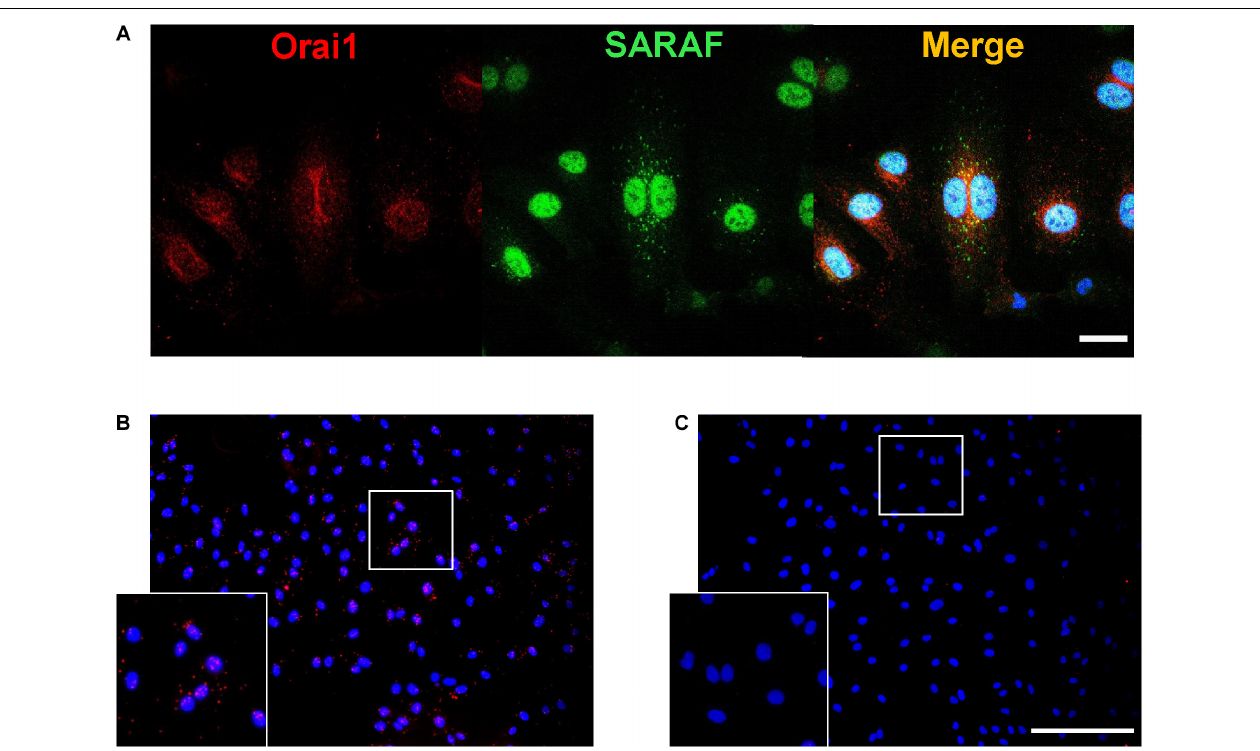
FIGURE 6 | SARAF and Orai1 colocalization in HUVECs. (A) Representative images with immunofluorescence ( × 40 objective with × 2 zoom; scale bar = 25 µ m) using specific antibodies show localization of SARAF (green) and Orai1 (red) in HUVECs stained with anti-rabbit SARAF and anti-mouse Orai1. Blue channel corresponds to DAPI. Merge image shows possible colocalization of SARAF with Orai1 as indicated by yellow color. (B,C) Representative images of fluorescence (20 × ; scale bar = 100 µ m) in HUVECs using primary antibodies against Orai1 and SARAF ( B: both; C: only Orai1) conjugated with the appropriate proximity ligation assay (PLA) probes. The bottom box is a zoom of ( B and C ) original images (20 × ). Red puncta indicate that proteins are in close proximity ( < 40 nm). HUVECs were cultured in the endothelial cell culture medium (EGM-2) enriched with growth factors, and nuclei are shown in blue as stained by